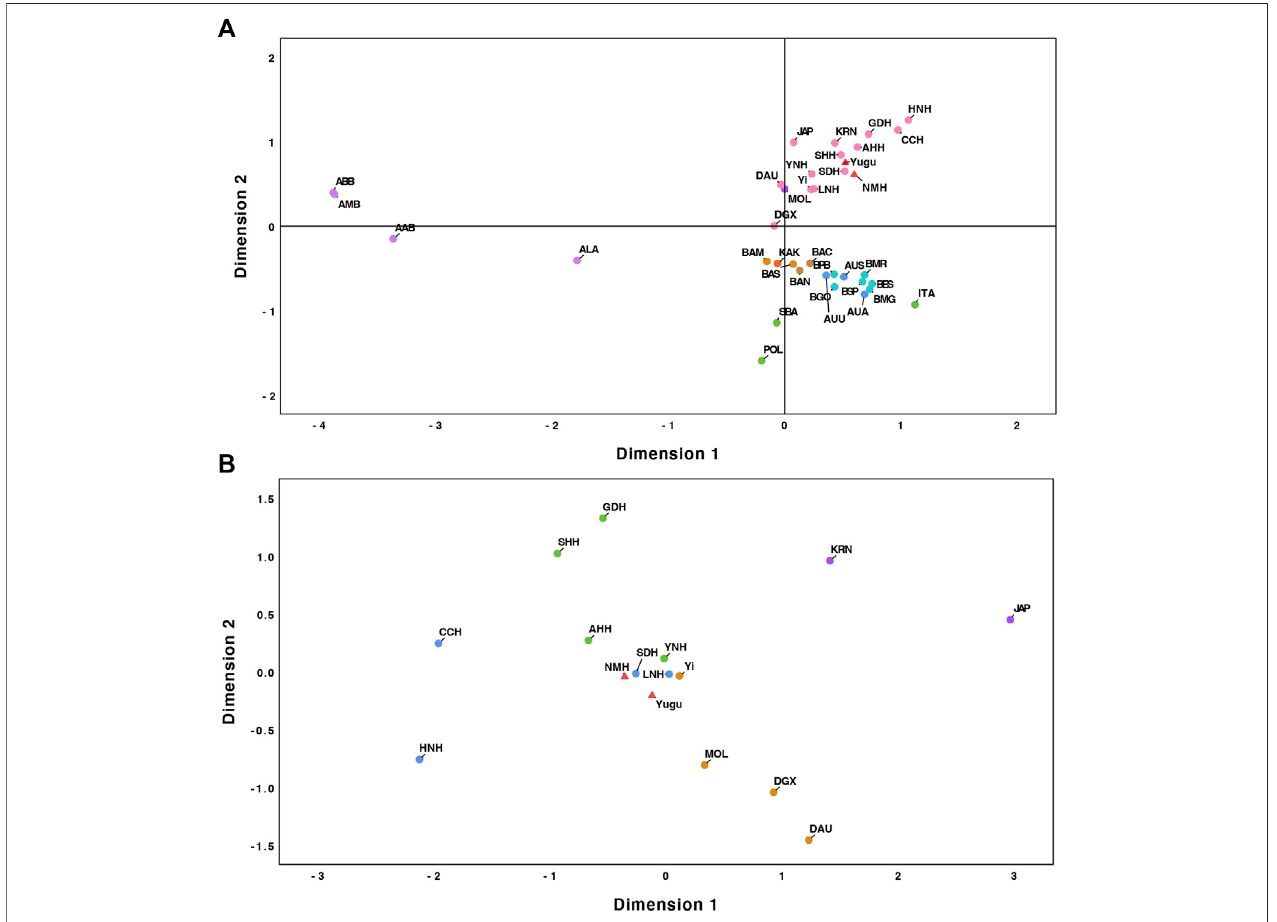
FIGURE 3 | (A) MDS analysis of the overall 37 populations; (B) MDS analysis among the studied populations and the reference populations from East